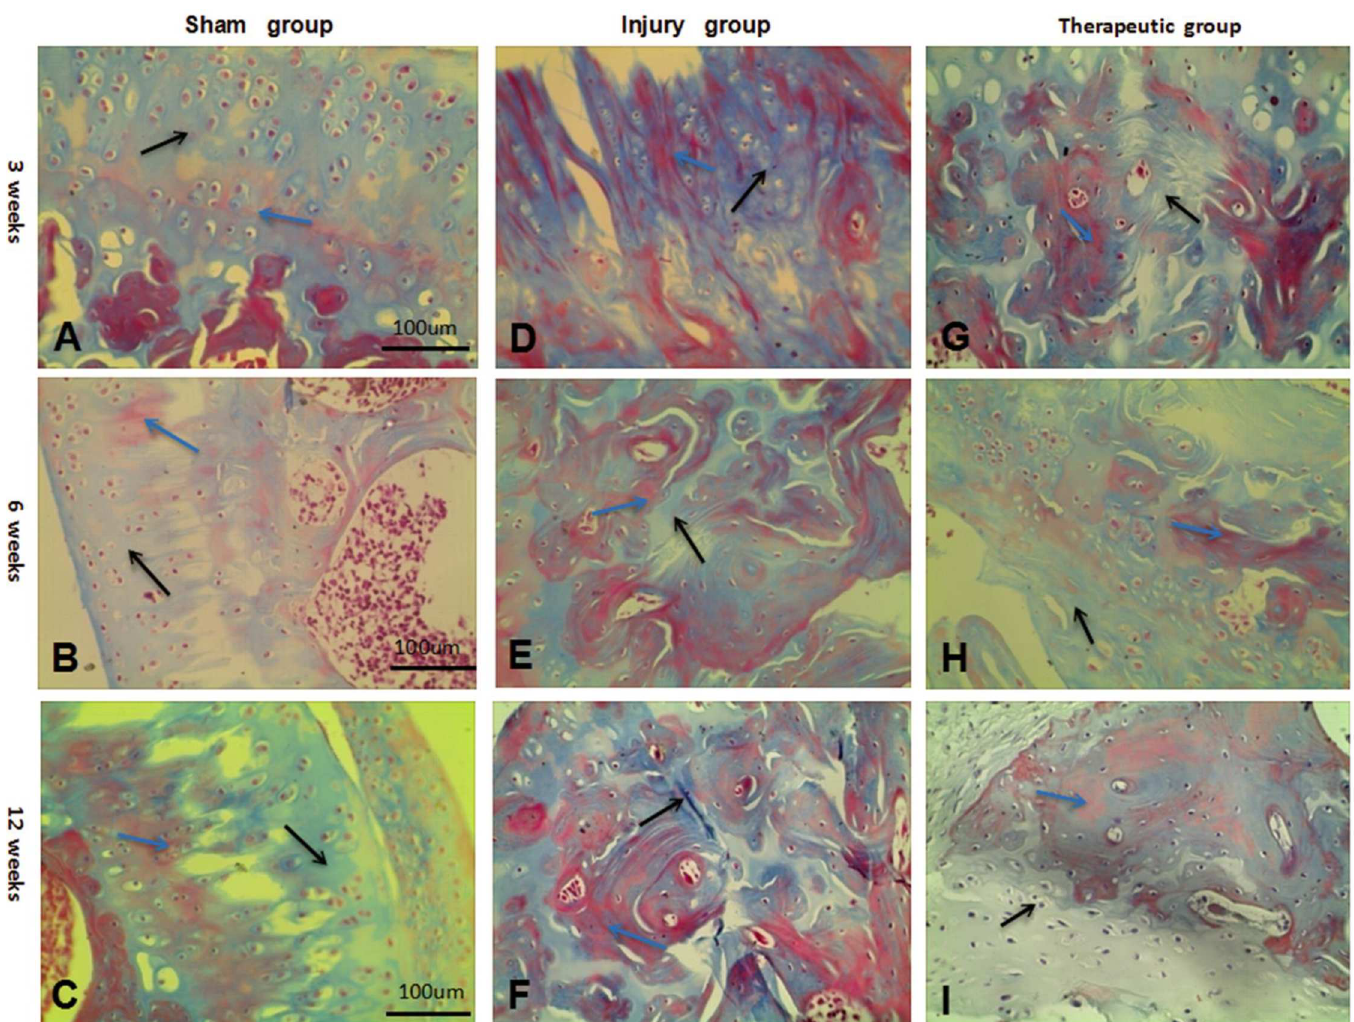
Fig 4. Masson staining in each group after 3,6,12 weeks. (A-C) Masson stainingin the sharm group after 3,6,12 weeks ( × 100).(D-F) Masson stainingin the injury group after 3,6,12 weeks ( × 100).(G-I) Masson stainingin the therapeuticgroup after 3,6,12 weeks ( × 100). Blue arrows:mature bonetrabecular. Black arrows:muscle fiber connectivetissue.